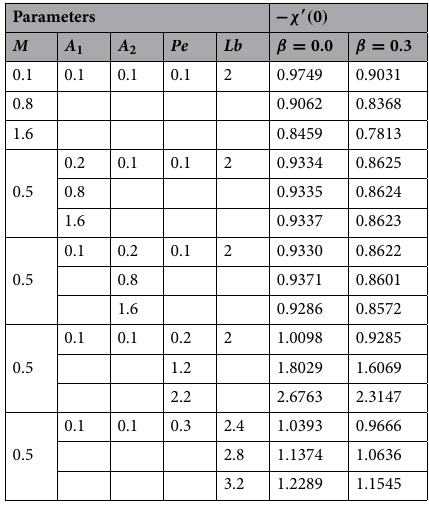
Table 5. Outcomes of − f ′′ ( 0 ) versus M , A 1 , A 2 , Pe and Lb